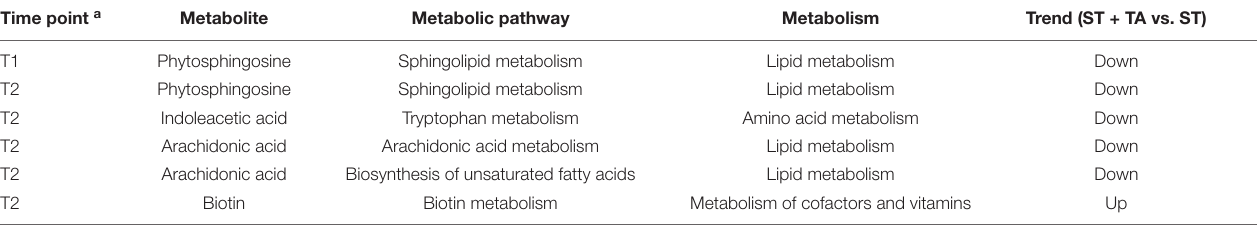
TABLE 1 | Significant metabolic pathways with its matched differential metabolites at varying time